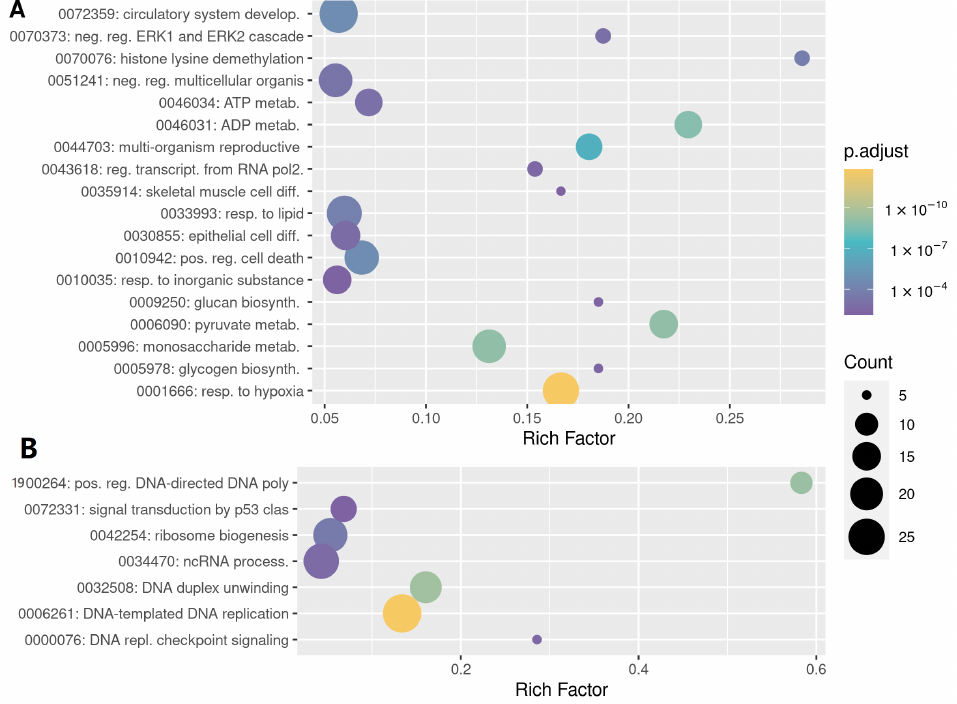
Figure 4. Functional enrichment analysis of the core hypoxic signature. Gene Ontology terms (Gene Ontology ID: Description) significantly enriched among the core of hypoxia up- ( A ) and down- ( B ) regulated genes. The analysis was restricted to terms of the “Biological process” domain. “Rich Factor”, represents the fraction of category genes regulated by hypoxia. Count, absolute number of category genes regulated by